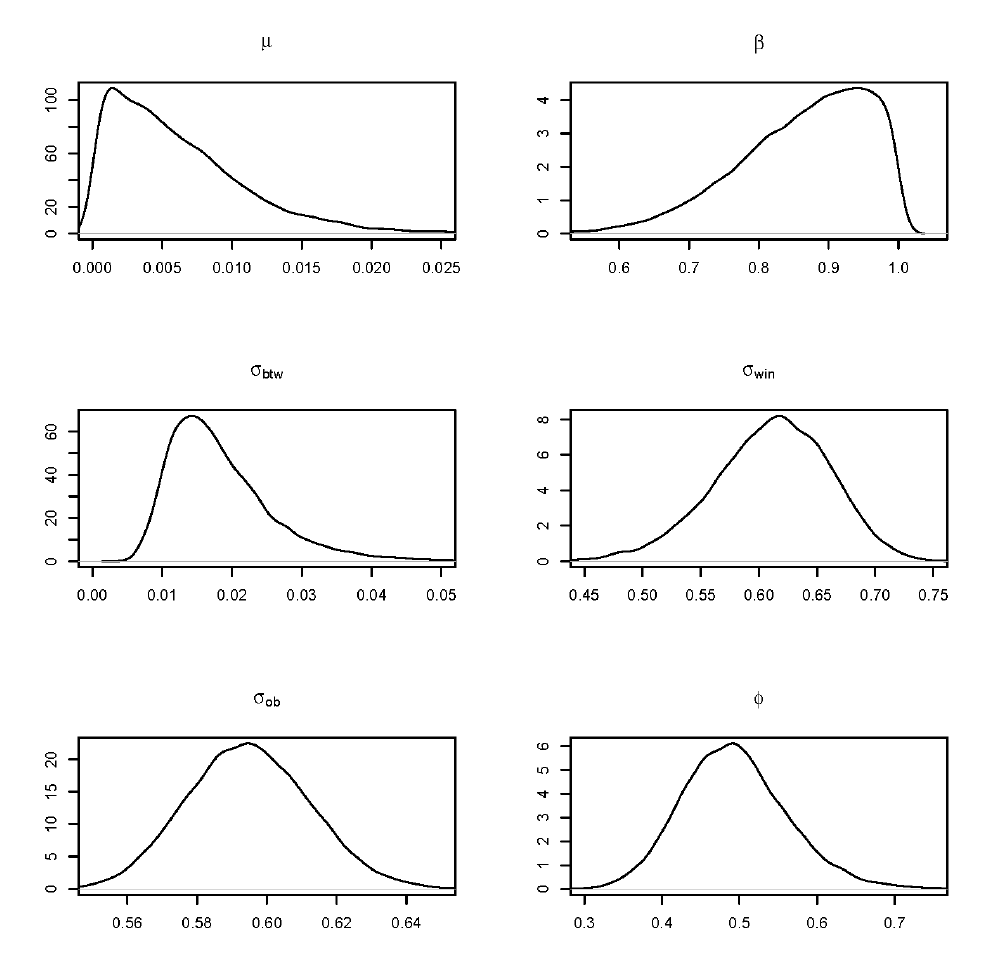
Figure 6. Marginal posterior distributions for model parameters. Distributions are estimated from the joint posterior distribution as represented by the Monte Carlo Markov Chain. The x -axis shows the likely range for each model